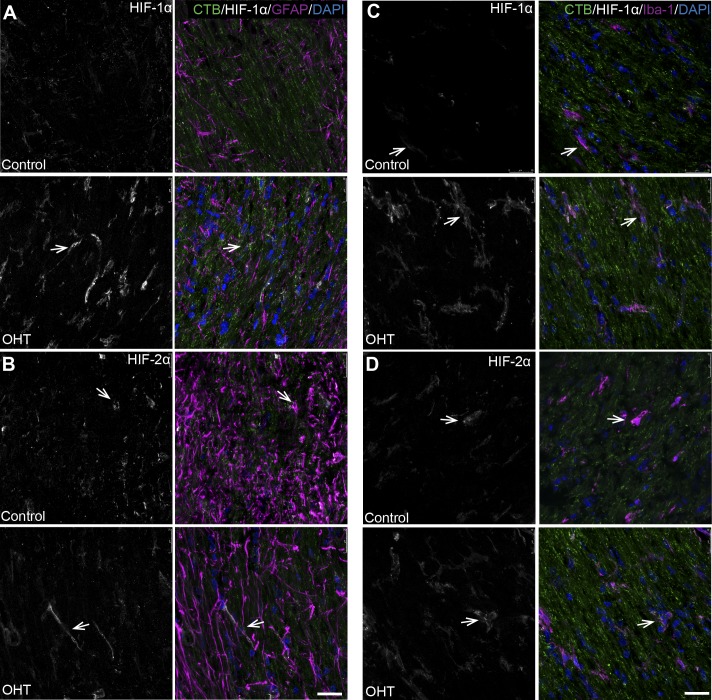
Colocalization of HIF-1α and HIF-2α with GFAP and Iba-1, with a significant increase of HIF-1α in ON after 4 weeks of OHT. Sections oriented so globe is superior. (A) Longitudinal section of OHT ON shows an increase in HIF-1α level (white) compared with control. Colocalization of HIF-1α (white) with GFAP (magenta) in astrocytes of OHT ON (arrows). (B) Longitudinal section of ON shows no difference in HIF-2α level (white) in OHT ON compared with control. Colocalization of HIF-2α (white) with GFAP (magenta) in astrocytes of ON (arrows). (C) Longitudinal section of OHT ON shows an increase in HIF-1α level (white) compared with control. Colocalization of HIF-1α (white) with Iba-1 (magenta) in microglia of ON (arrows). (D) Longitudinal section of ON shows no difference in HIF-2α level (white) in OHT ON compared with control. Colocalization of HIF-2α (white) with Iba-1 (magenta) in astrocytes of ON (arrows). CTB (green) and DAPI (blue). n = 3 independent control ONs and 3 independent OHT ONs. Scale bar: 25 μm.